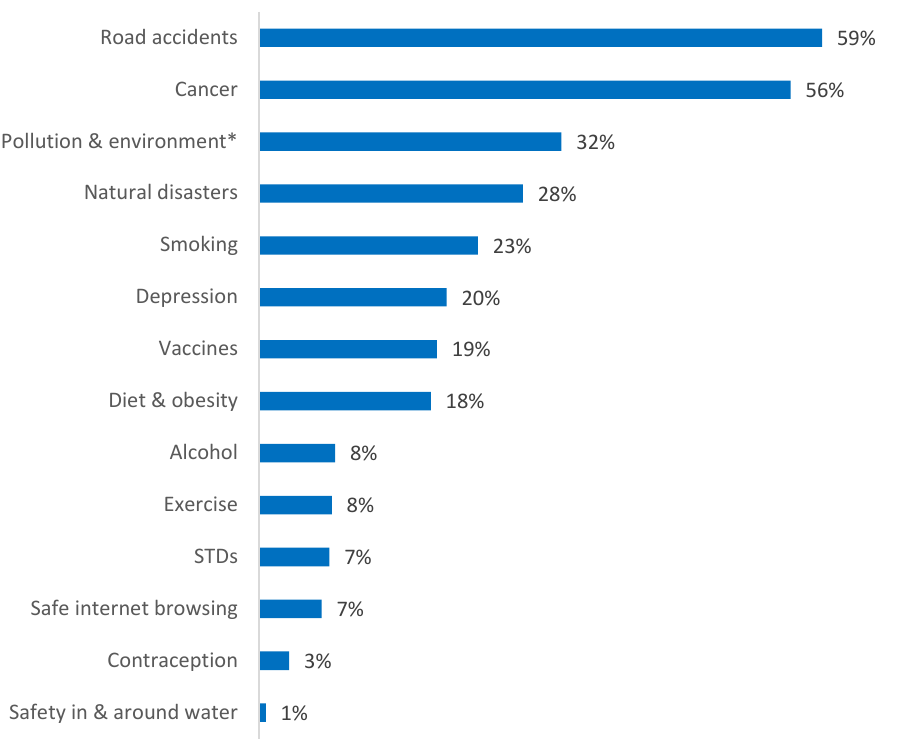
Figure 2. Most important public health risk (up to 3 choices per person); * Pollution and environment stands for air pollution and environmental protection; STDs, Sexually transmitted diseases.